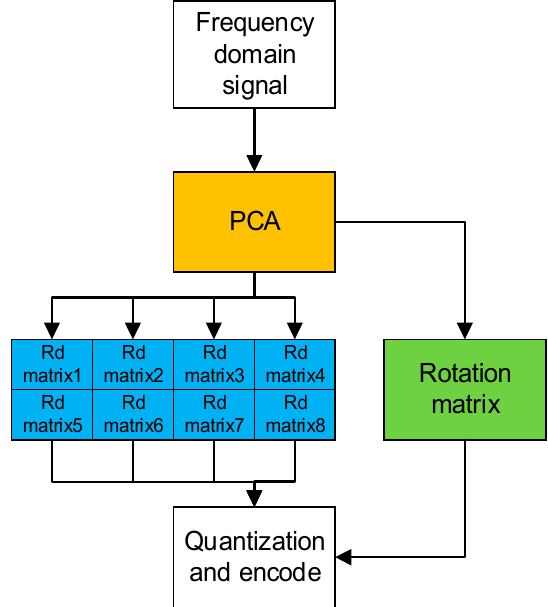
Figure 7. Multi-frame in encoder. (PCA, Principle Component Analysis; Rd, reduced-dimensional).